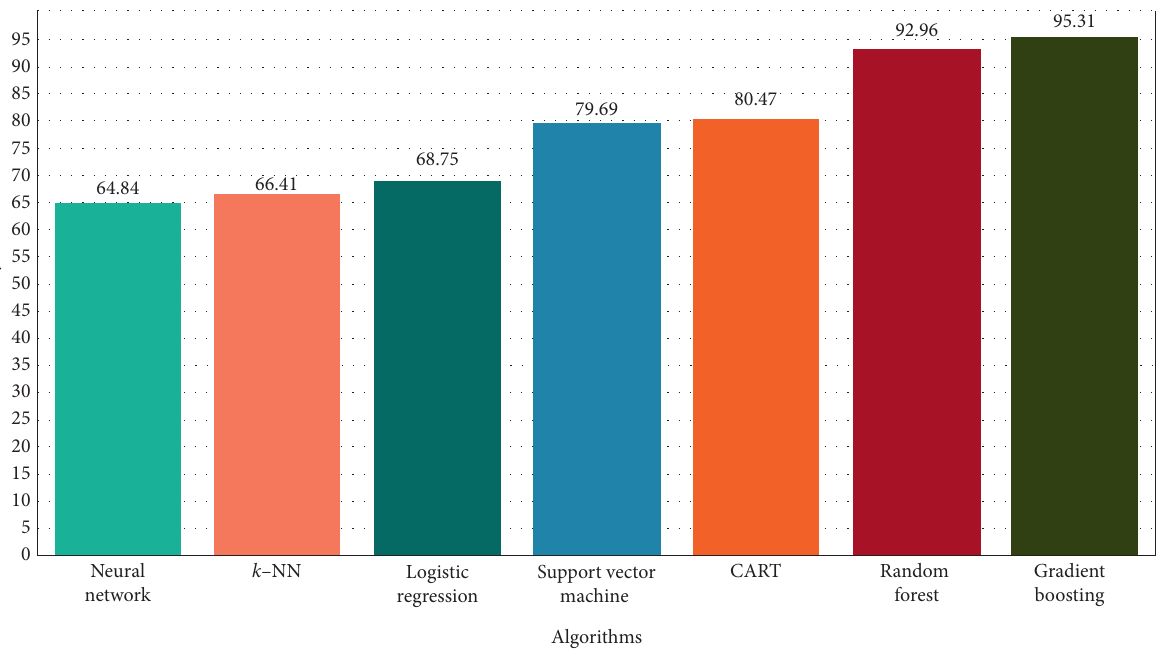
Figure 3: Accuracy percentages of algorithms.